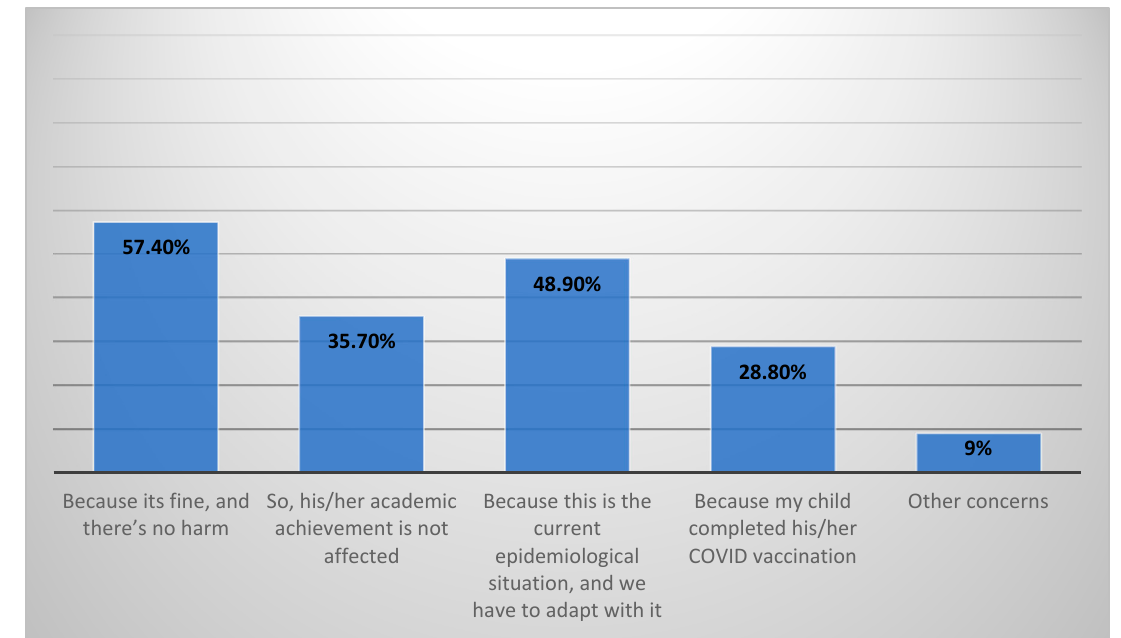
Figure A2. Parents’ reasoning for not giving their teenager children Booster COVID-19 vaccine.